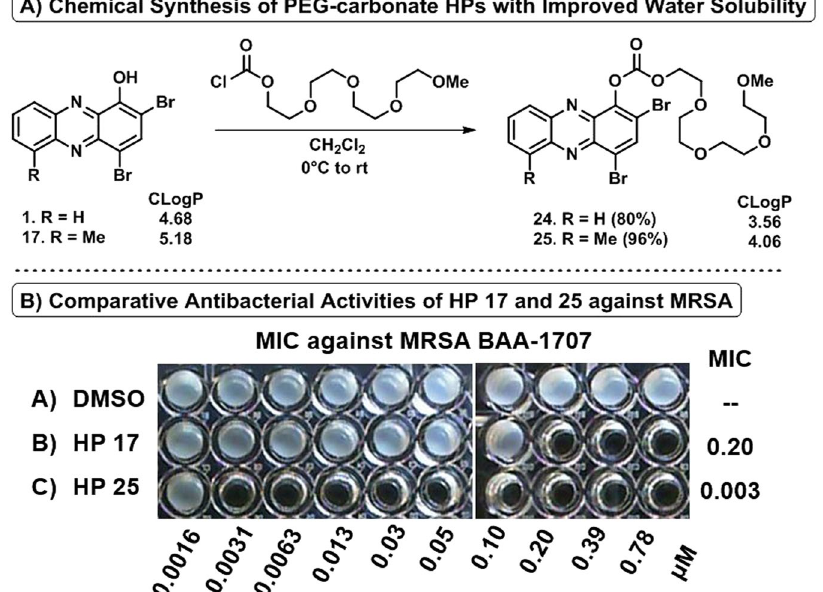
Figure 5. ( A ) Chemical synthesis of PEG-carbonate HPs 24 and 25. ( B ) Antibacterial assay of PEG-carbonate HP 25 alongside non-carbonate version HP 17 demonstrating enhanced antibacterial activities against